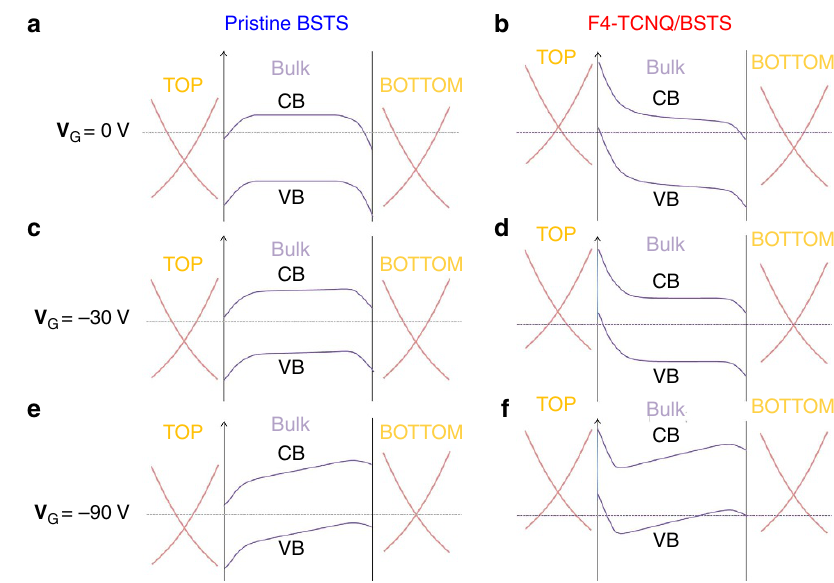
Figure 4 | Electronic structure of the present TPNJ device. The electronic structure of pristine BSTS and F4-TCNQ/BSTS in a topological p-n junction device under ( a , b ) V G ¼ 0V, ( c , d ) V G ¼ (cid:2) 30V and ( e , f ) V G ¼ (cid:2) 90V. A high resistance state of TPNJ in the bottom surface can be switched on/off by tuning the chemical potential of the trivial surface accumulation